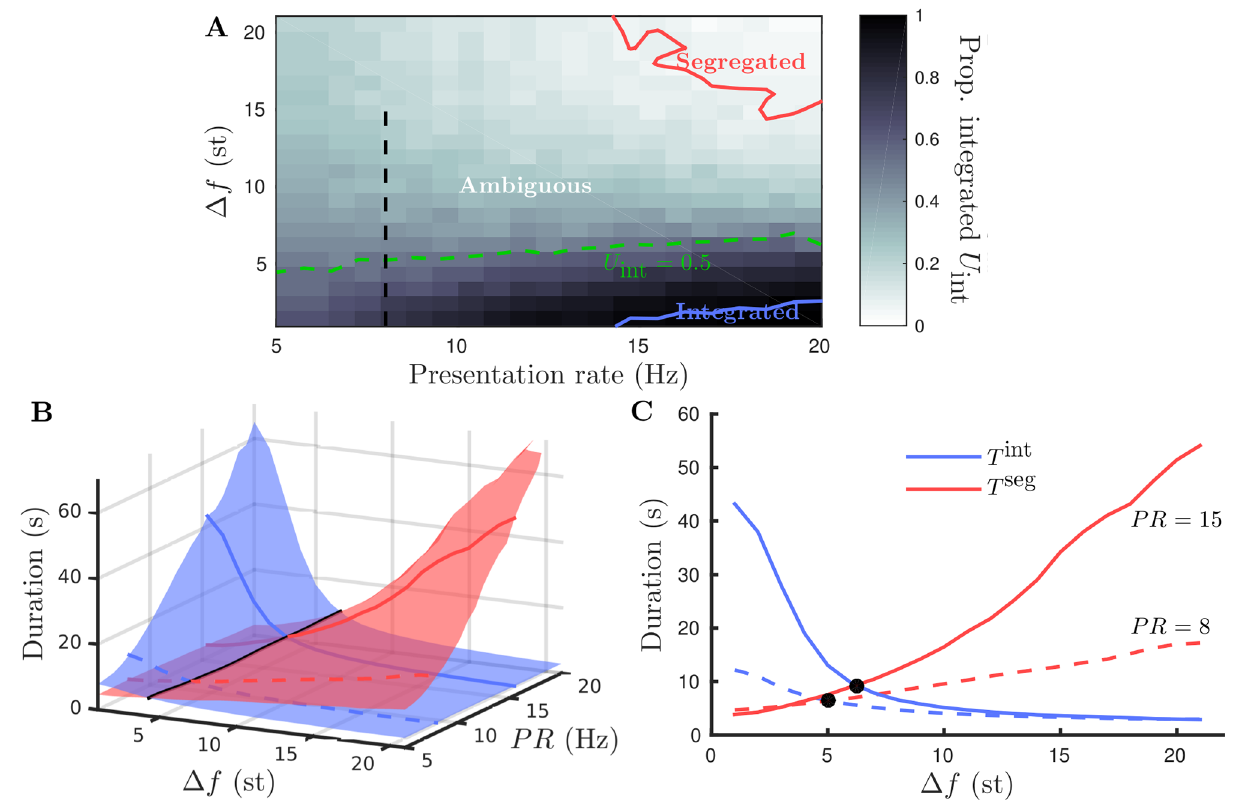
Fig 10. Perceptual organization for stimulus parameters in model ( e dyn , i gbl ). A : Proportion integrated U int varying Δ f and PR plotted as a grayscale map. Solid are contours at U int = 0.05 (red) and U int = 0.95 (blue) demarcating regions where segregated and integrated are considered dominant, respectively. A dashed green contour in the ambiguous region indicates equidominance U int = 0.5. Vertical dashed line at PR = 8 corresponds to the frequency difference sweep used in Figs 8 and 9. B : Surface plots of mean duration integrated and mean duration segregated (not normalized) across the same range as A. Black curve is the intersection of the two surfaces (equidominance). Dashed and solid curves indicate the cross sections plotted in C at PR = 5 and PR = 15, respectively. C : Durations integrated and segregated varying Δ f for fixed PR as indicated; in each case the equidominance point is a black dot.